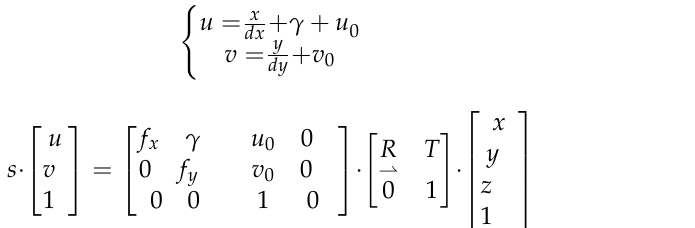
Figure 4. Schematic diagram of the binocular model. (2)